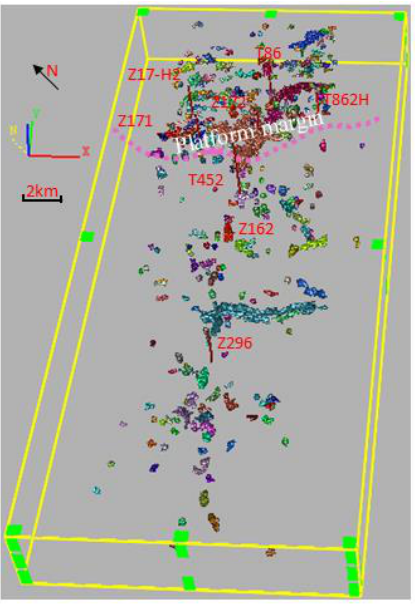
Figure 9. 3D visualization of the fractured reservoirs along the strike-slip fault F I 17 in the north- western area (the NW-trending bands showing the reef-shoal reservoirs, and the spots showing the fracture-cave reservoirs which are distributed along the NE-trending strike-slip fault zone).